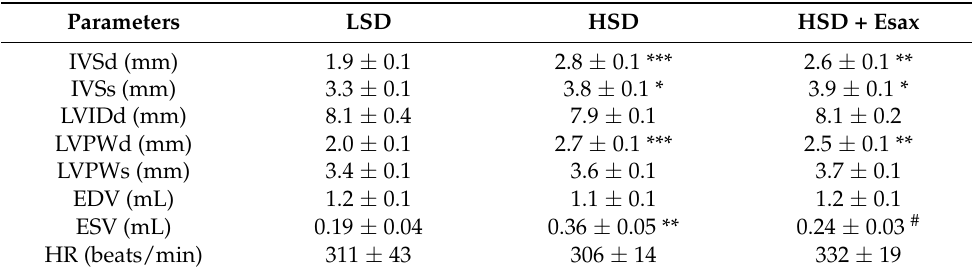
Table 2. Echocardiographic data at 16 weeks of